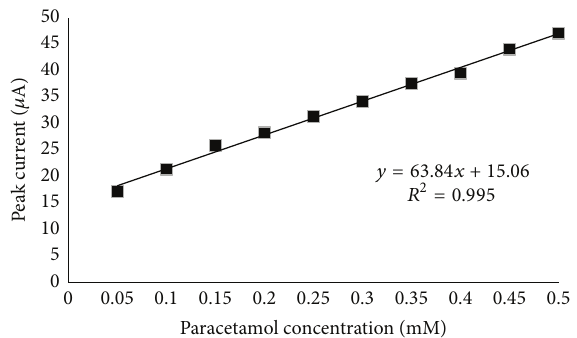
Figure6:Standardcalibrationplotofparacetamolin0.1 MKH 2 PO 4 using a SWCNT/Ni-modified electrode versus Ag/AgCl.